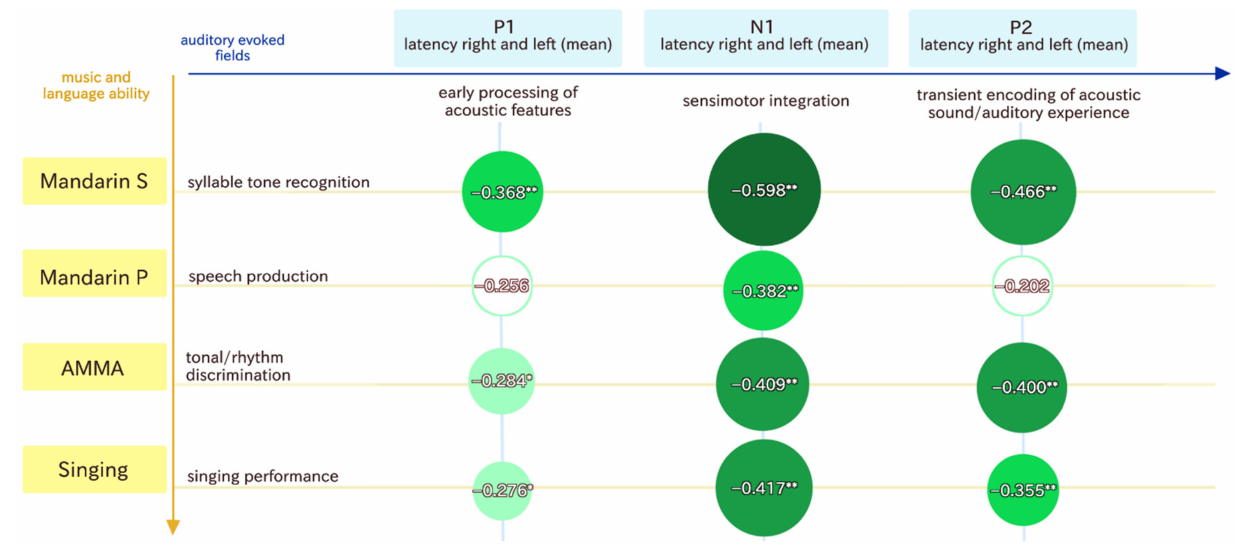
Figure 2. This figure shows the correlations between the P1, N1, and P2 responses and the behavioral variables. * means significant at the 0.05 level (2-tailed), and ** means that correlations are significant at the 0.01 level. The color green represents the effect size of the correlation coefficient. The darker the green, the larger the